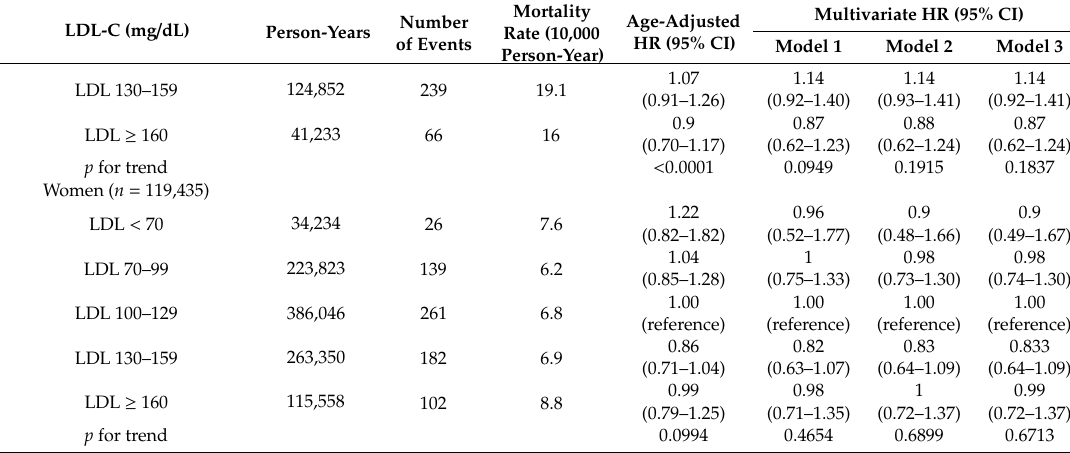
Table 8. Risk of cancer mortality according to baseline LDL-C levels excluding subjects who died within 3 years of follow up in KoGES